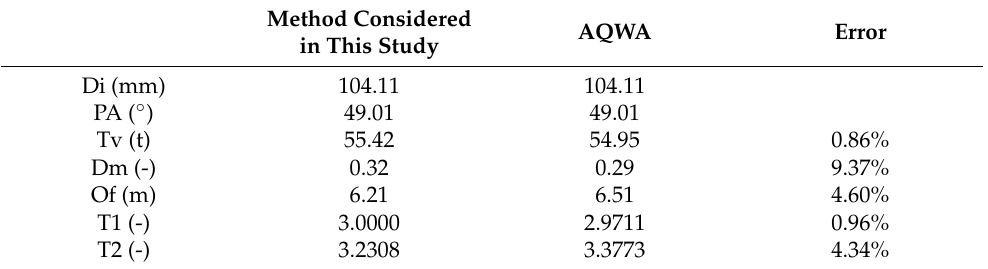
Table 2. Linear function adaptive sampling optimization results.